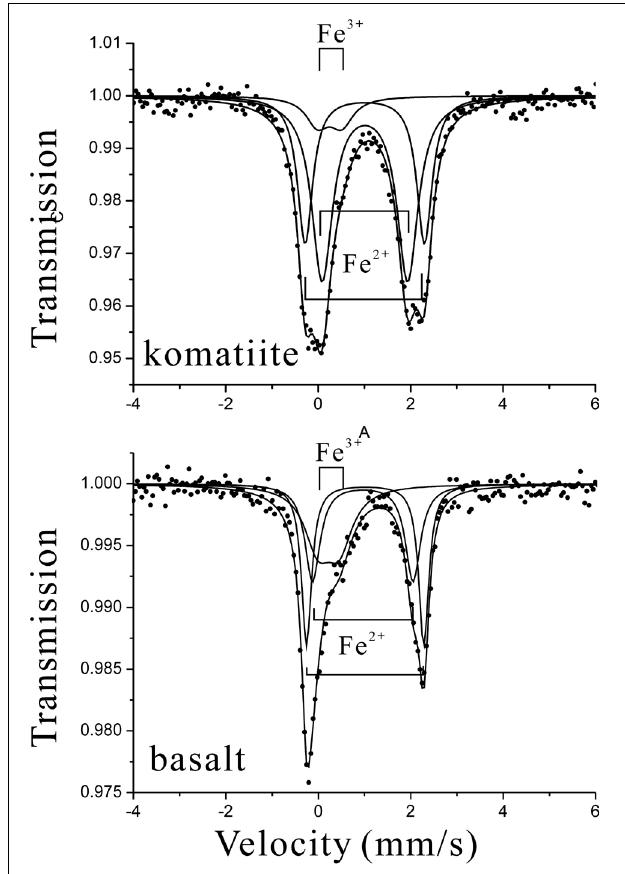
FIGURE 2 | Mössbauer spectroscopy of komatiite and basalt used for the batch experiments. As both komatiite and basalt are made of multiple minerals/materials with multiple crystallographic sites of Fe 2 + and Fe 3 + , their Mössbauer spectroscopic profiles were fitted with two paramagnetic Fe 2 + -doublets and one Fe 3 + -doublet.